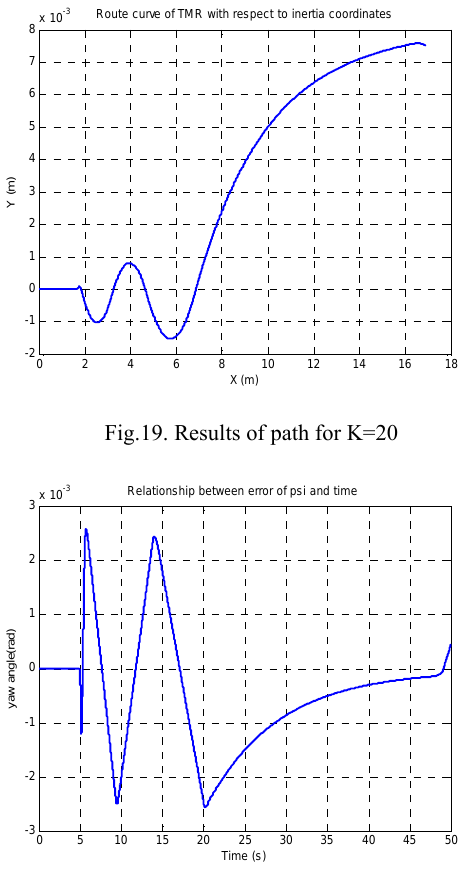
Fig.20. Results of error of ψ for